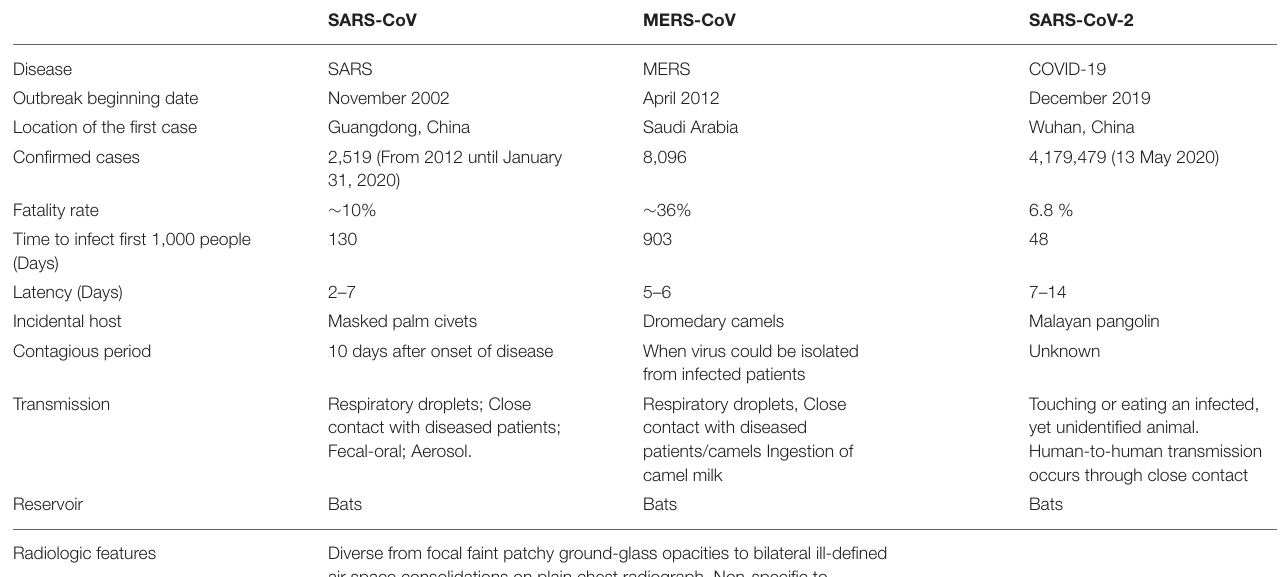
TABLE 1 | Characteristics of patients with SARS-CoV-2, SARS-CoV, and